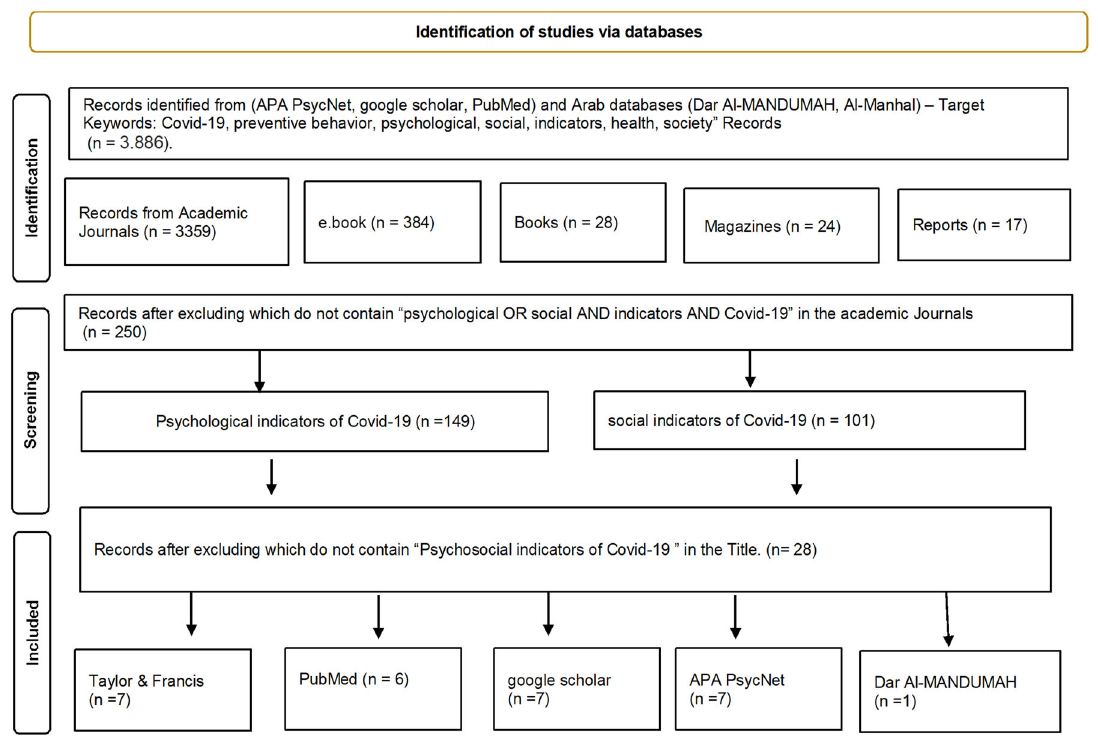
Fig. 1 PRISMA Flow Diagram. PRISMA 2020 fl ow diagram for included searches of databases and other